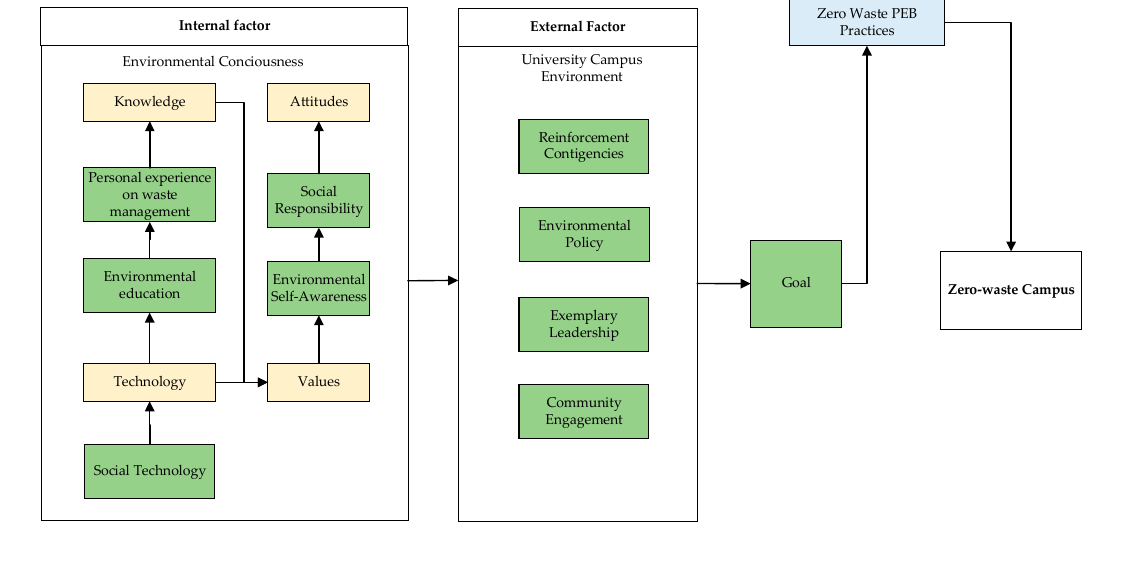
Figure 5. Zero-Waste Campus Framework.